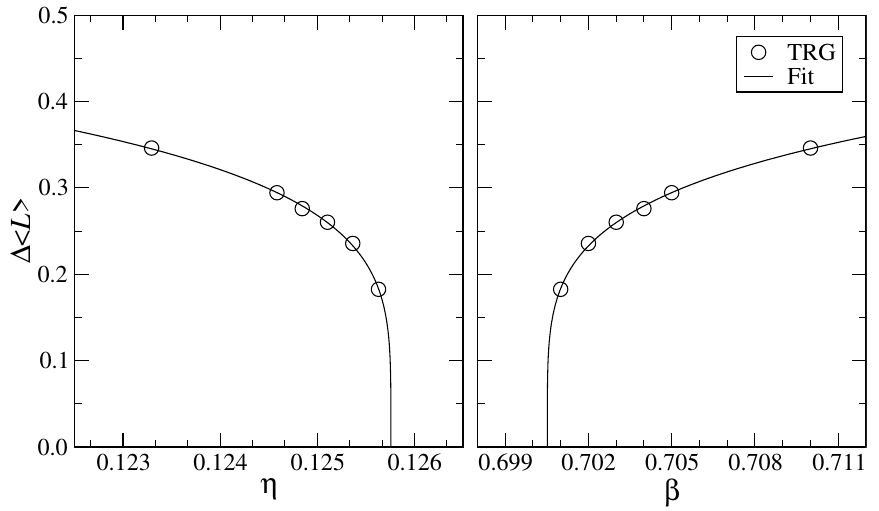
Figure 5 . (Left) Fit of ∆ h L i at µ = 0 as a function of η . (Right) Fit of ∆ h L i at µ = 0 as a function of β .